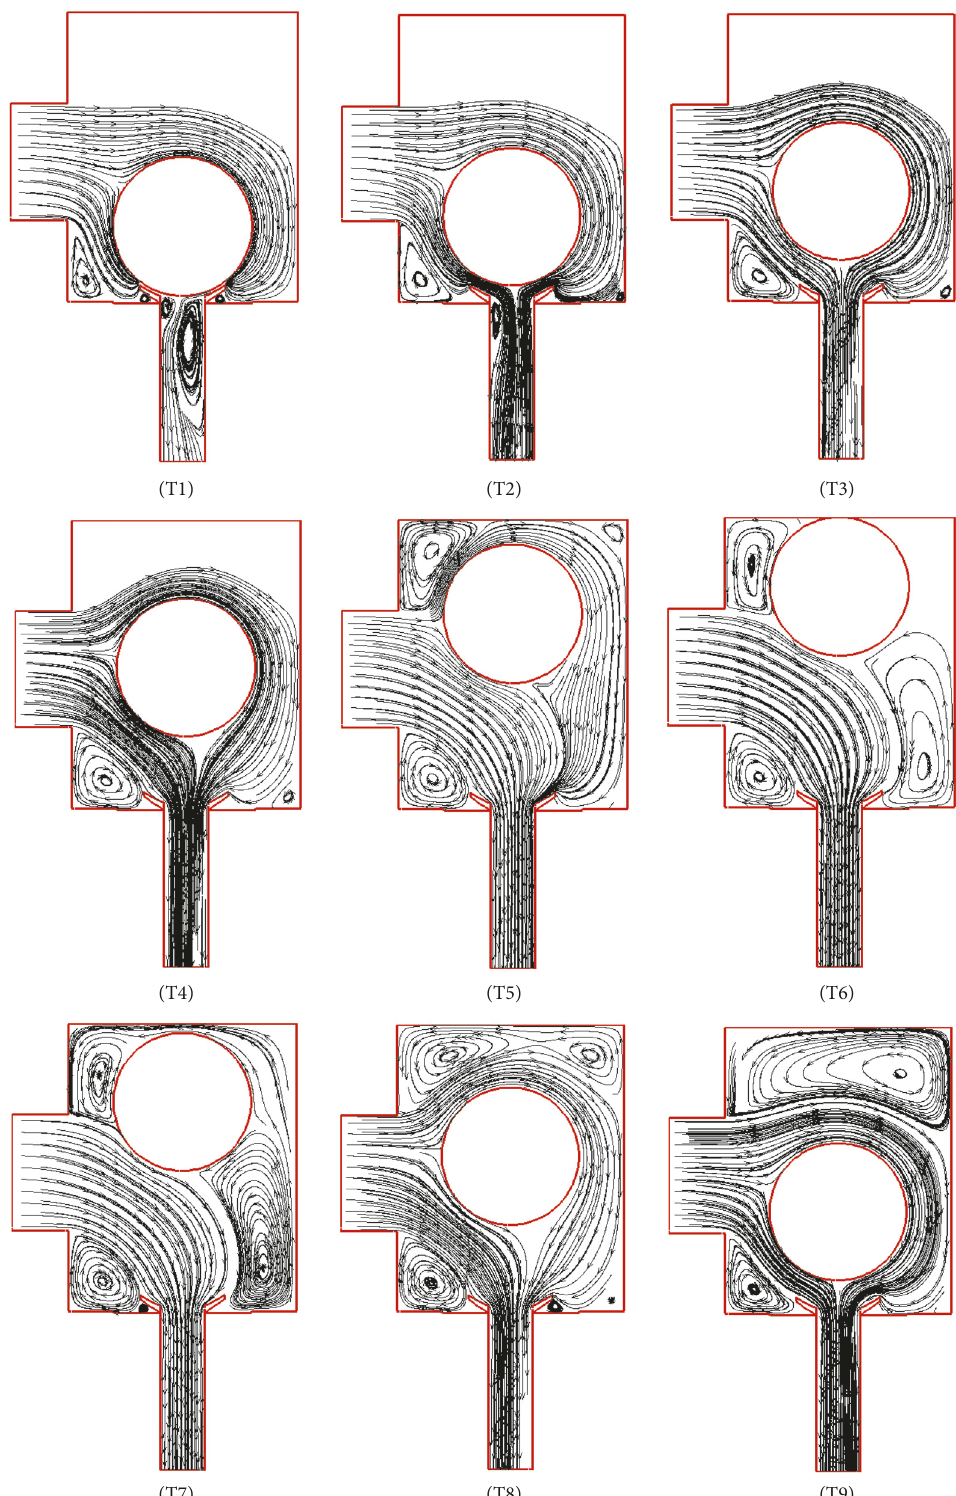
Figure 4: Streamtraces during movement of the floating